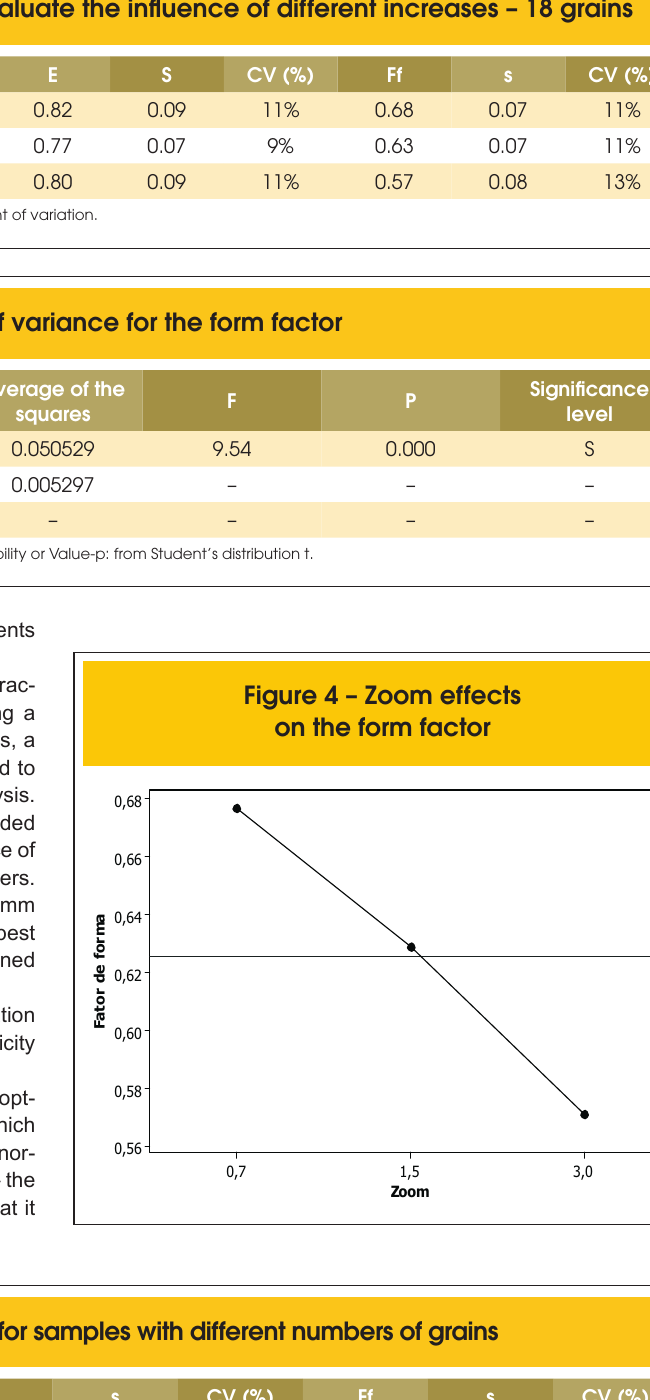
Table 3 – Form parameters calculated to evaluate the influence of different increases – 18 grains